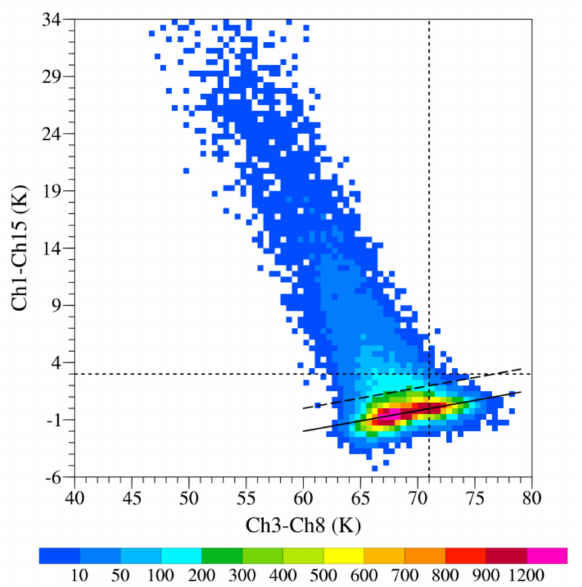
Figure 2. Data counts at 0.5-K intervals of brightness temperature difference from NOAA-18 AMSU-A nadir observations over Amazon area (1 o S − 4 o N, 53 o W − 59 o W) during 2005 to